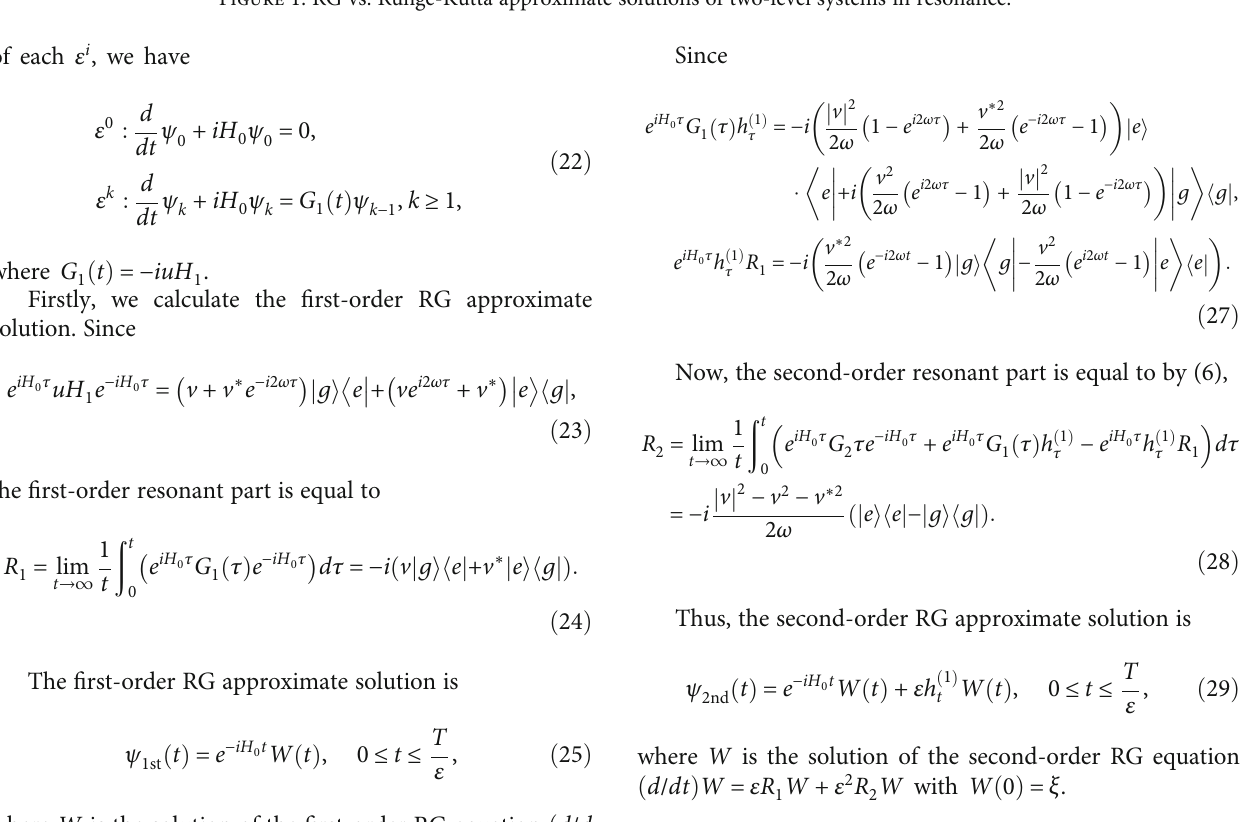
Figure 1: RG vs. Runge-Kutta approximate solutions of two-level systems in